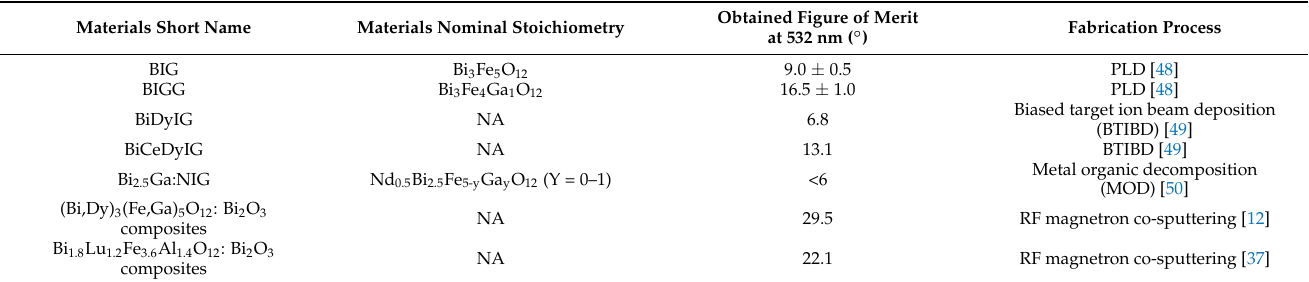
Table 2. List of Bi-substituted iron garnet materials with their corresponding measured MO quality factors in the visible spectral range, and their fabrication processes